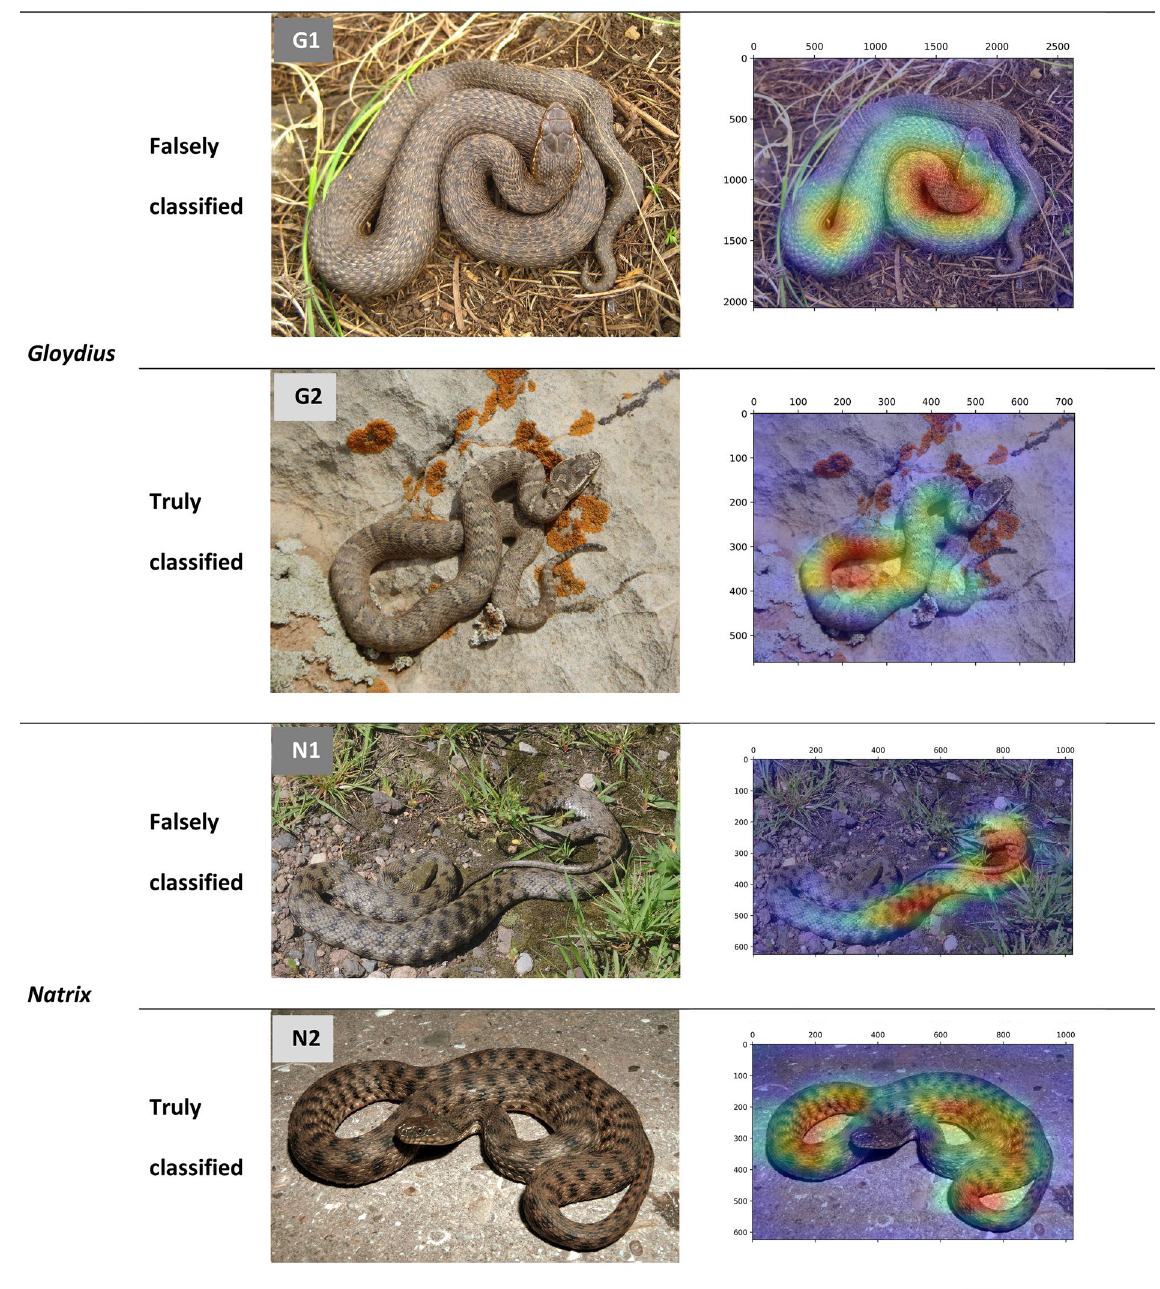
Figure 7. The heatmap visualization of discriminative regions within the last activation layers of VGG-16 model, in truly and falsely classified images of Gloydius and Natrix Patel et al. 10 used a region-based convolutional neural network (R-CNN) for the detection and classification of nine snake species in Galápagos Islands and Ecuador; and using ResNet algorithm, they obtained an accuracy of around 75%, and using VGG-16, they obtained an accuracy of around 70% (Table 6).